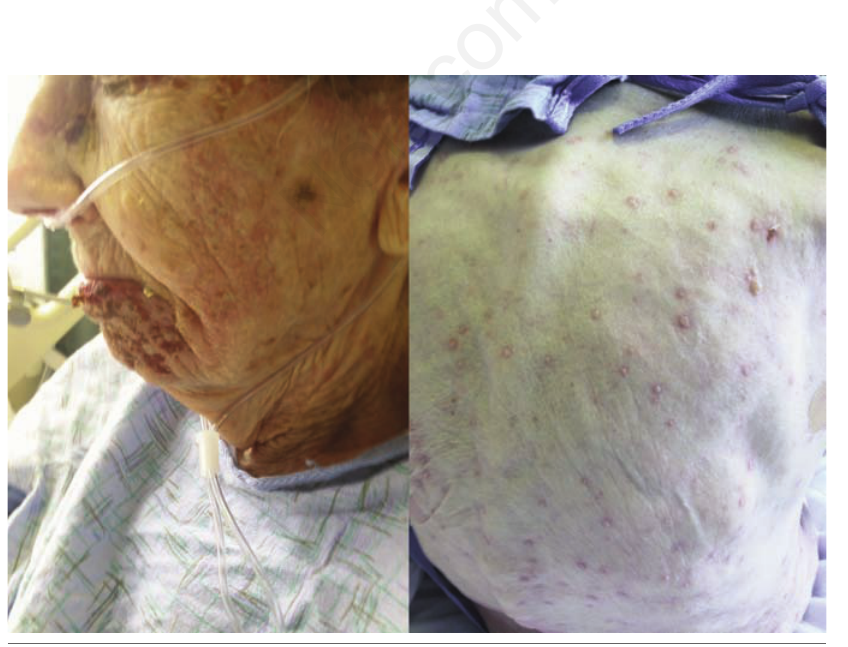
Figure 1. Clinical photograph of a patient with disseminated cutaneous herpes zoster. On the left, cluster of vesicular lesions involving the mandibular branch of the trigeminal nerve. On the right, diffuse vesicular rash with erythematous base involving the